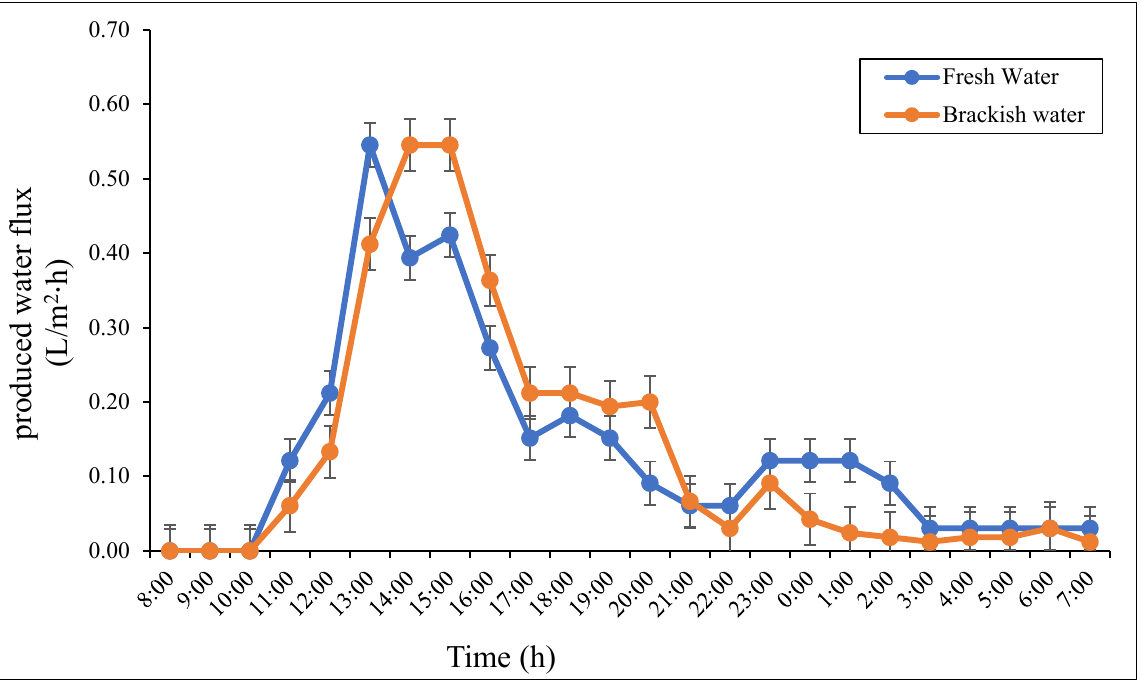
Figure 10. Effect of the salinity of the input water on the water production rate.